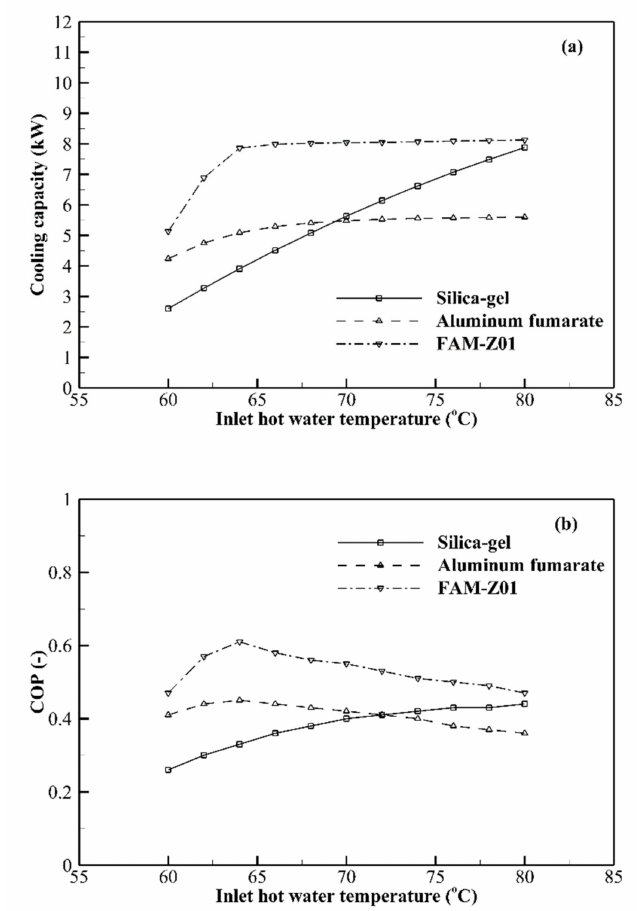
Figure 6. Influence of inlet hot-water temperature on: ( a ) cooling capacity and ( b )